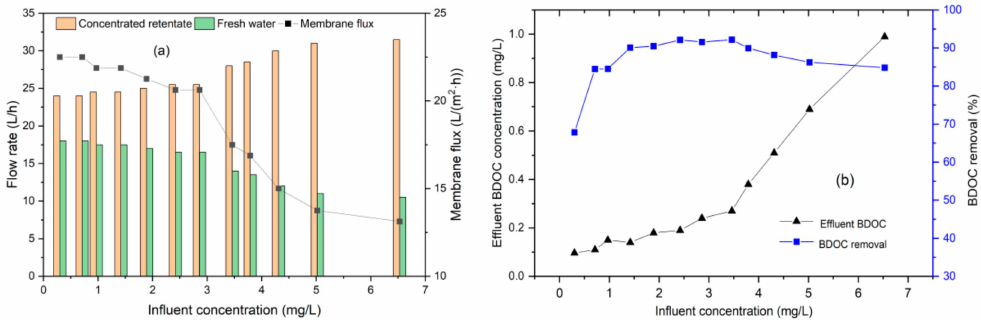
Figure 7. The influence of influent concentration of BDOC on UF performance. ( a ) Membrane flux; ( b ) BDOC removal.